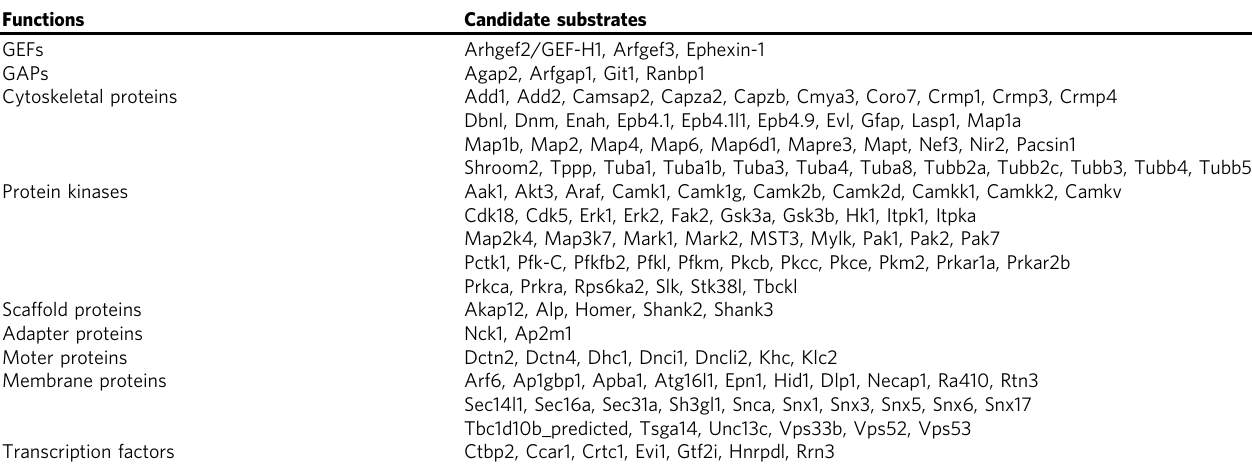
Table 1 Candidate substrates of CaMKI in neurons Functions Candidate